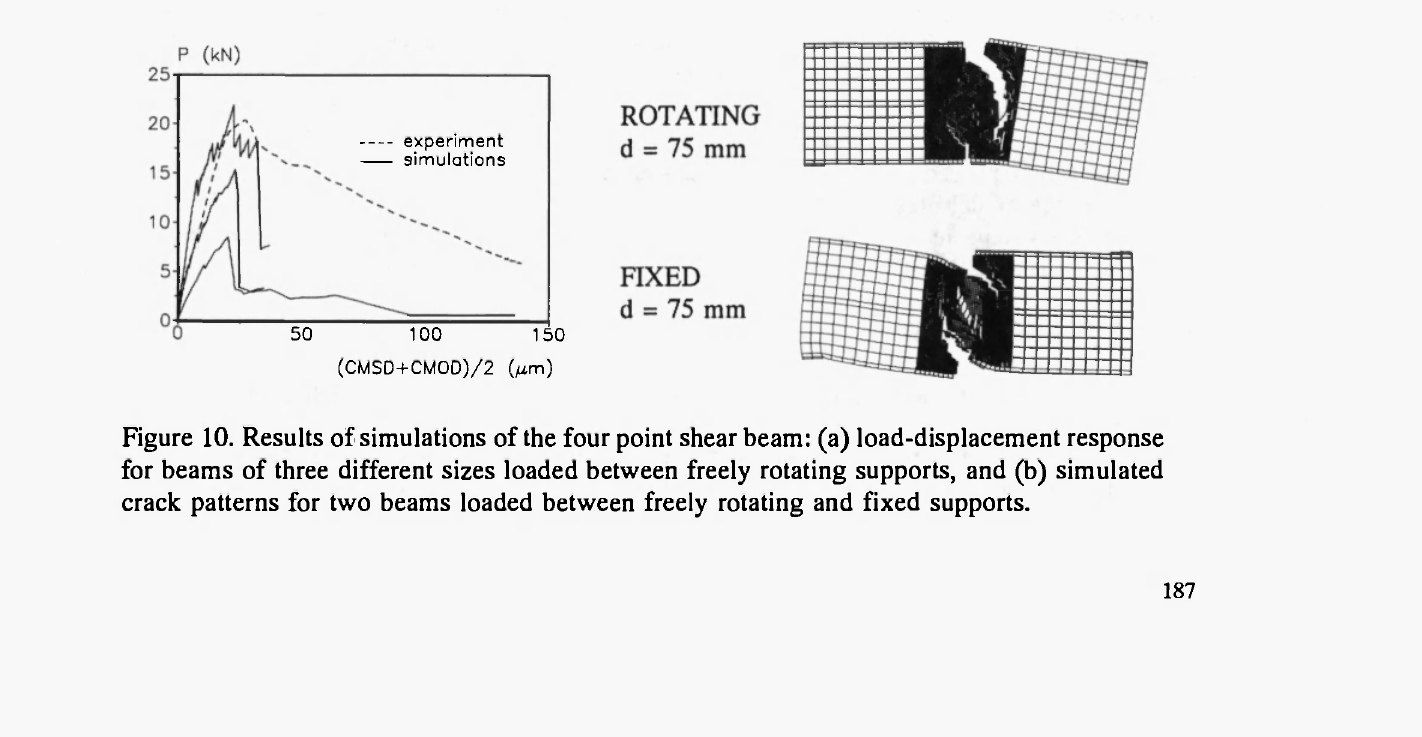
Figure 10. Results of simulations of the four point shear beam: (a) load-displacement response for beams of three different sizes loaded between freely rotating supports, and (b) simulated crack patterns for two beams loaded between freely rotating and fixed